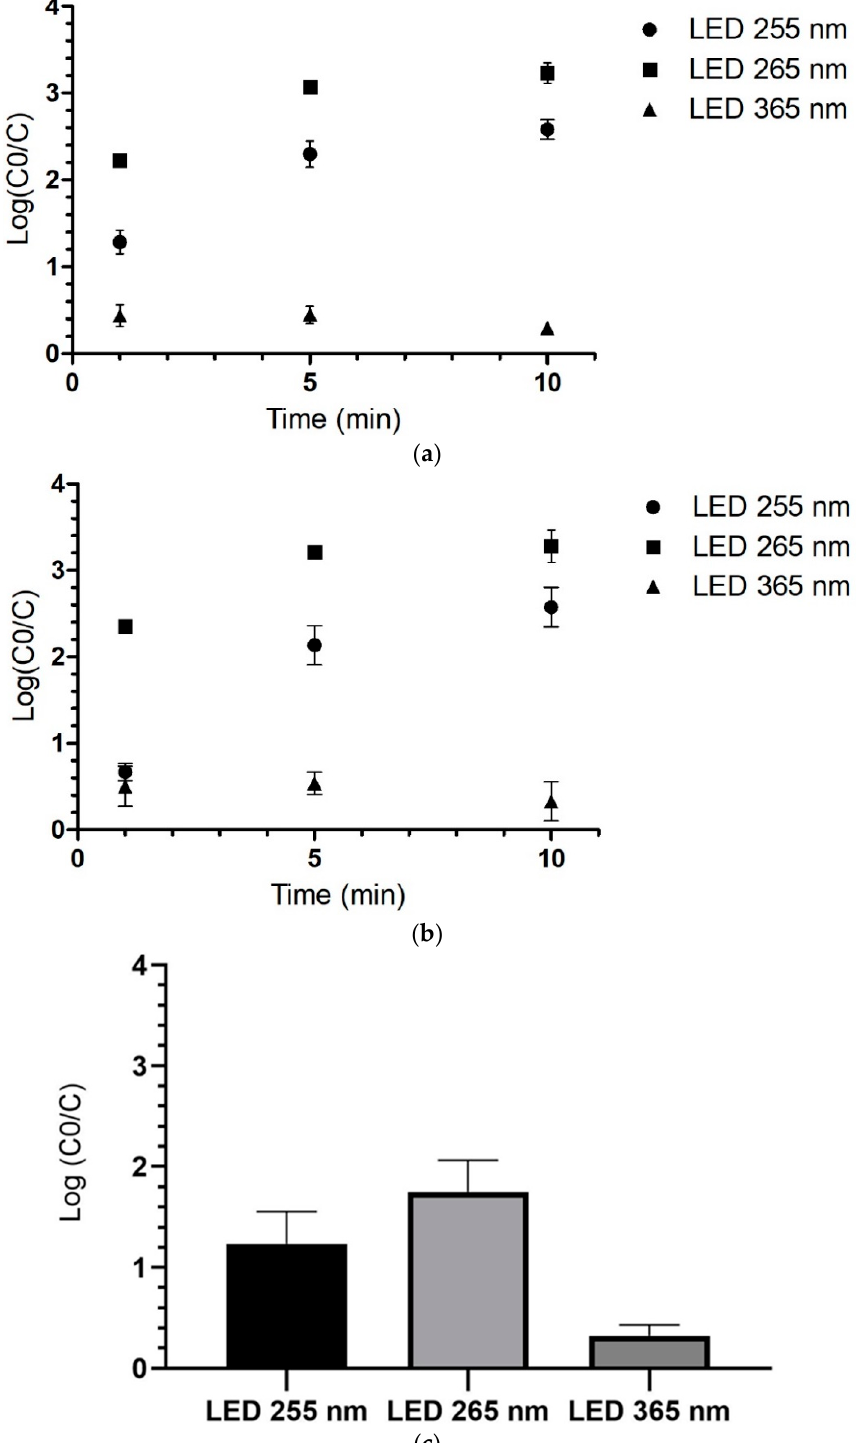
Figure 1. Log inactivation using LEDs that emit at 255, 265 and 365 nm after 10 min of exposure (that correspond to 12, 58 and 1653 mJ/cm 2 , respectively); ( a ) total coliforms, ( b ) E. coli and ( c ) fungi. Data are expressed as means of two independent experiments. Error bars represent duplicate results.